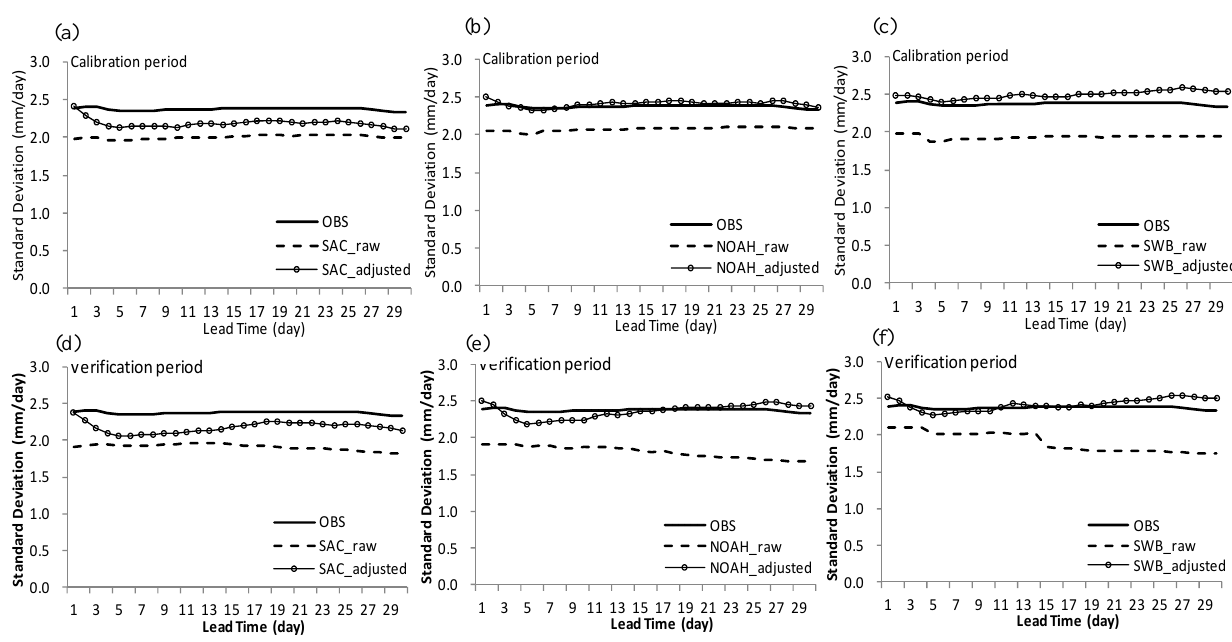
Fig. 4. The mean standard deviations of observed ensemble, raw ensemble, GLMPP adjusted ensemble for the SAC, SWB and NOAH models.